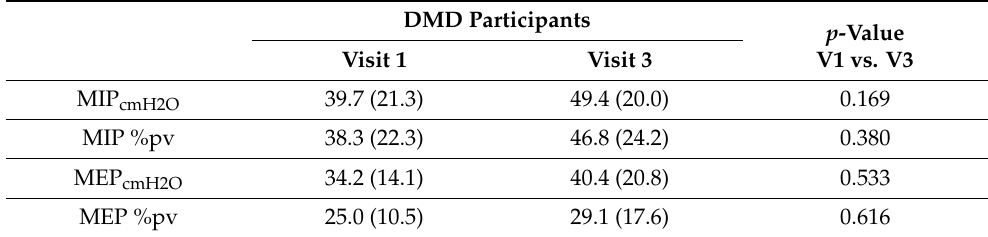
Table 5. Values of respiratory muscle